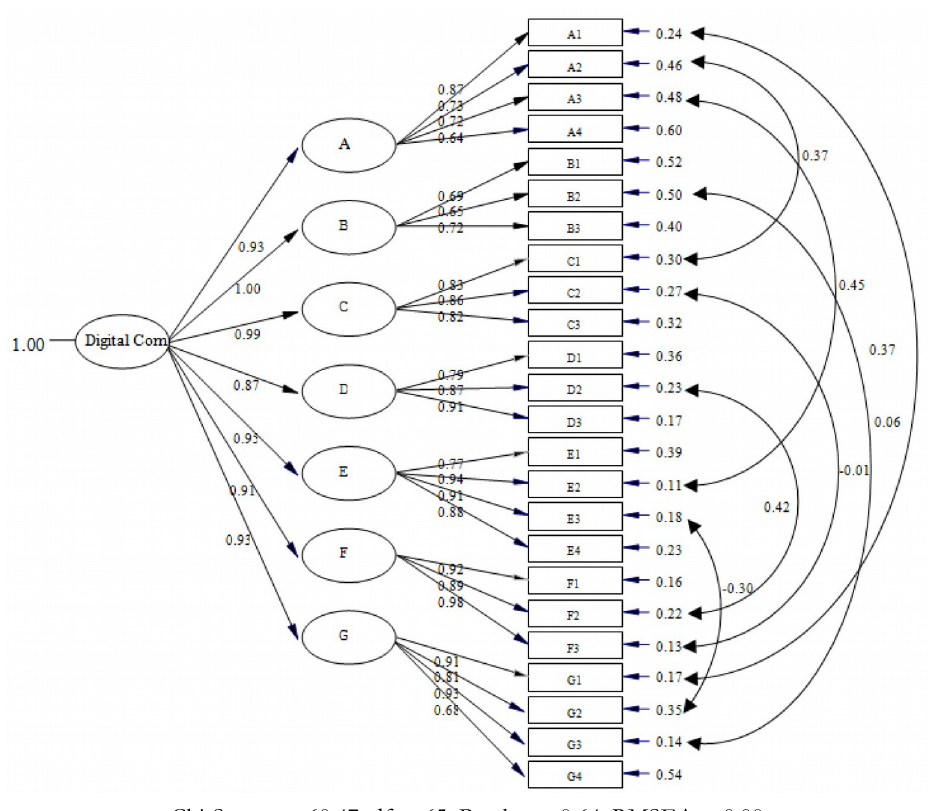
Figure 1. Model diagram of the 2 nd Order confirmatory factors of the essential digital